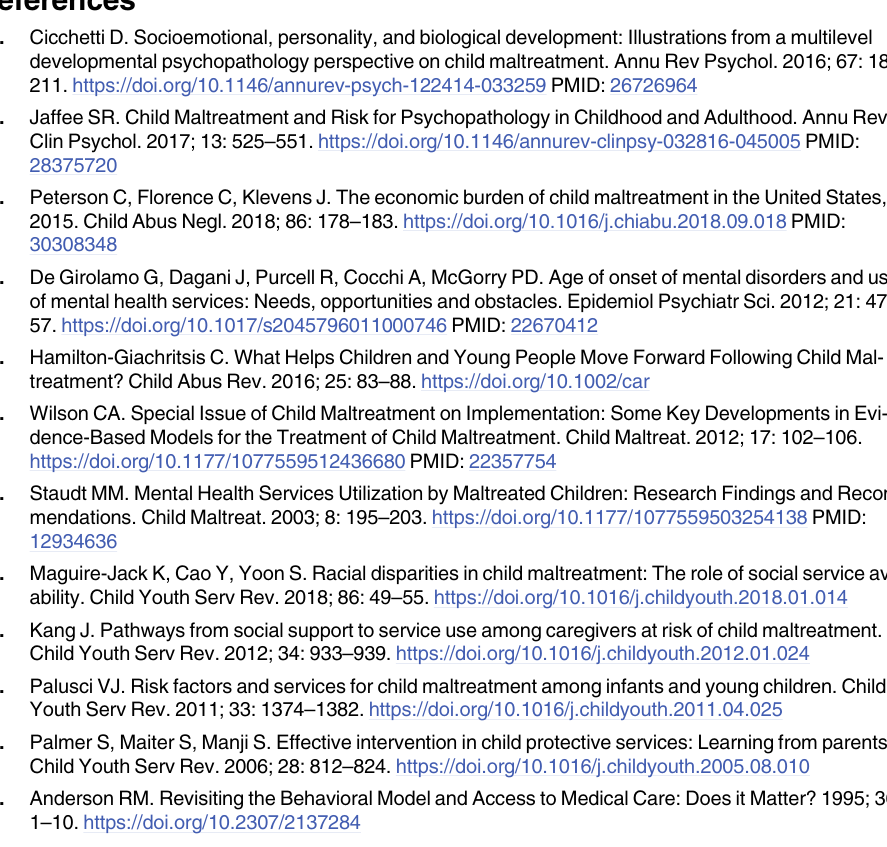
S1 Fig. Crosstab visualization of important classifiers: Perceived need for adolescent counseling services. S2 Fig. Crosstab visualization of important classifiers: Utilization of adolescent counseling